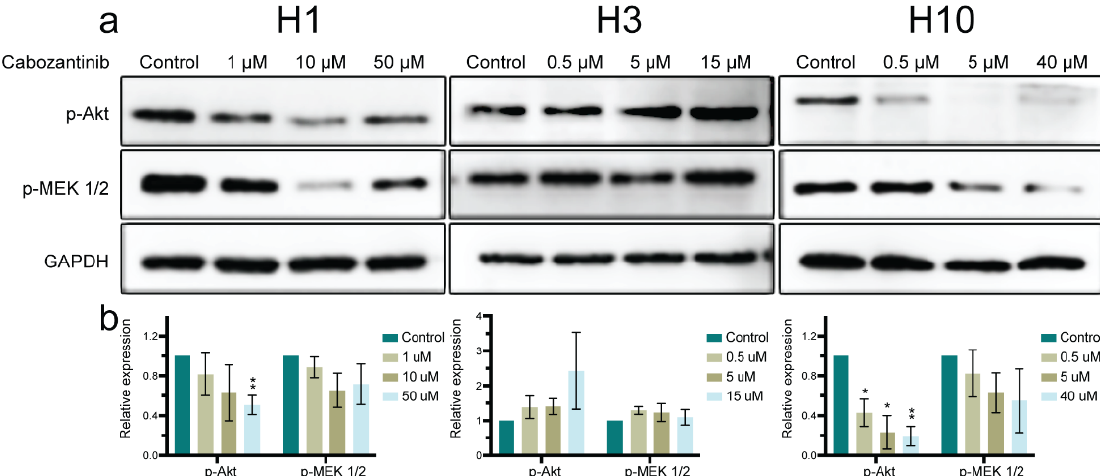
Figure 7. p-Akt and p-MEK 1/2 protein expression levels are downregulated after cabozantinib treatment. ( a ) Western blots showing the expression levels of p-Akt and p-MEK 1/2 after treatment with 1 μ M, 10 μ M or 50 μ M (H1), 0.5 μ M, 5 μ M or 15 μ M (H3) and 0.5 μ M, 5 μ M or 40 μ M (H10) cabozantinib for 72 h, respectively, compared with the untreated (control) cells. The Western blot (WB) experiments were performed in triplicate. ( b ) Quantification of the target proteins detected in the WBs. The expression level of the target proteins was normalized against GAPDH and compared relatively as a ratio to the control for each specific protein. The WB experiments were performed in triplicate. Full-length blots are presented in Supplementary Figure 5b. *: p < 0.05; **: p < 0.01.